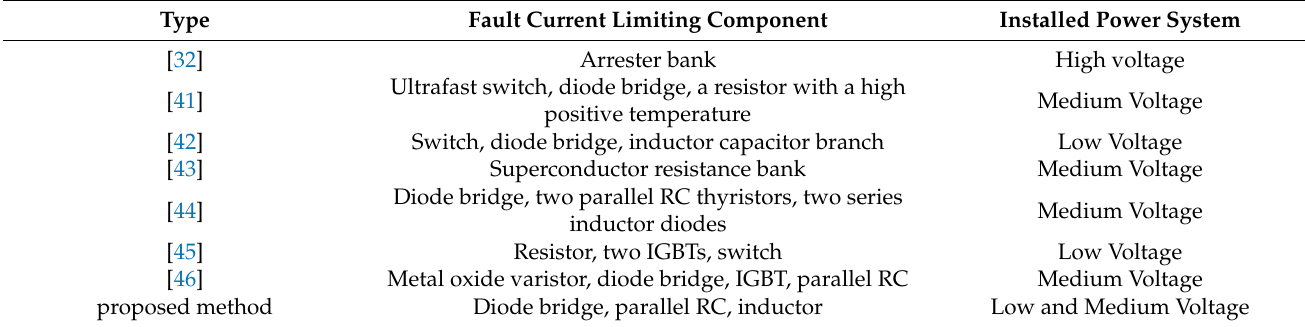
Table 5. Comparison of the proposed DC FCL with the existing